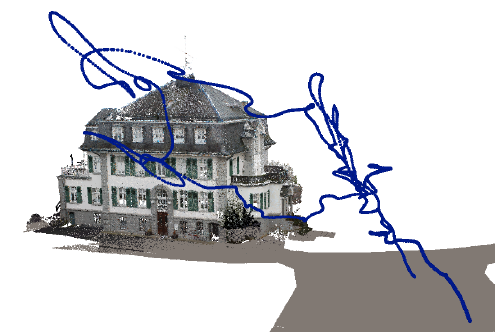
Figure 2. Trajectory of the UAV flight capturing the images of the B UILDING dataset overlayed with a 3D model of a near-by building.